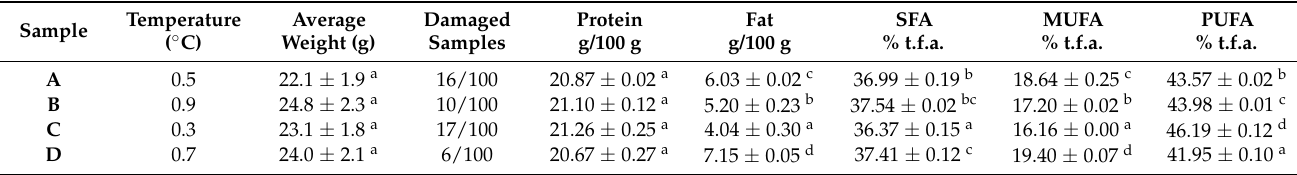
Table 3. Temperature, average weight, number of samples with visible physical damage, crude protein and fat content, and saturated (SFA), monounsaturated (MUFA), and polyunsaturated (PUFA) fatty acid content of samples A and B handled by traditional method, and samples C and D handled by modified handling